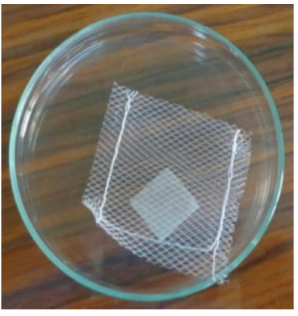
Figure 1. A special holder for the film